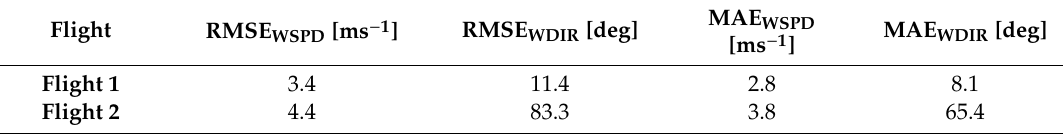
Table 4. Summary of RMSE and MAE for wind speed and direction for both